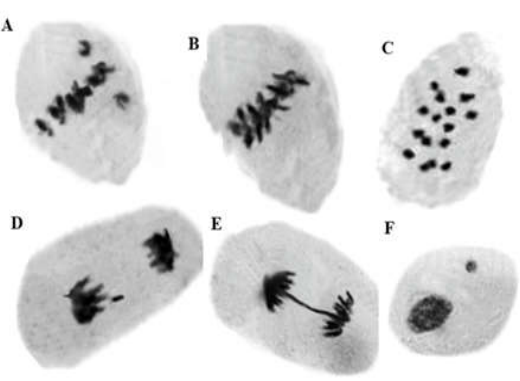
Fig. 3 . Different chromosomal abnormalities in root tip cells of heavy metal-induced T. foenum-graecum ; (A) precious movement of chromosome; (B) sticky chromosome; (C) C-mitosis; (D) laggard; (E) bridge; (F)